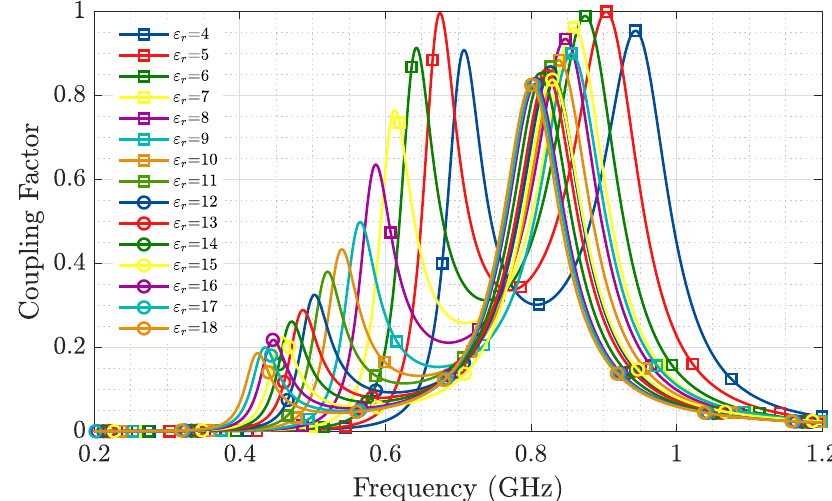
Figure 4. Antenna impedance coupling factor between the wrapped bow tie T-match antenna and the RFID-IC for ε r between 4 and